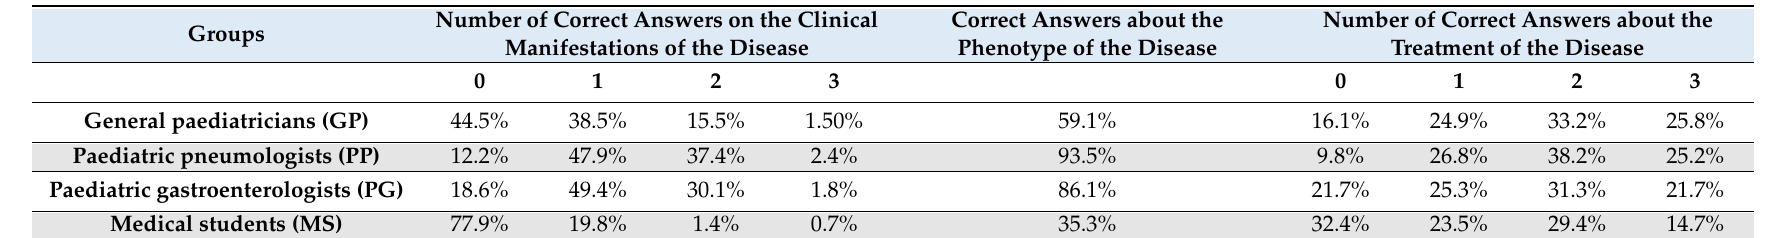
Table 2. Correct answers to the alpha-1 antitrypsin deficiency (AATD) knowledge questionnaire. Groups